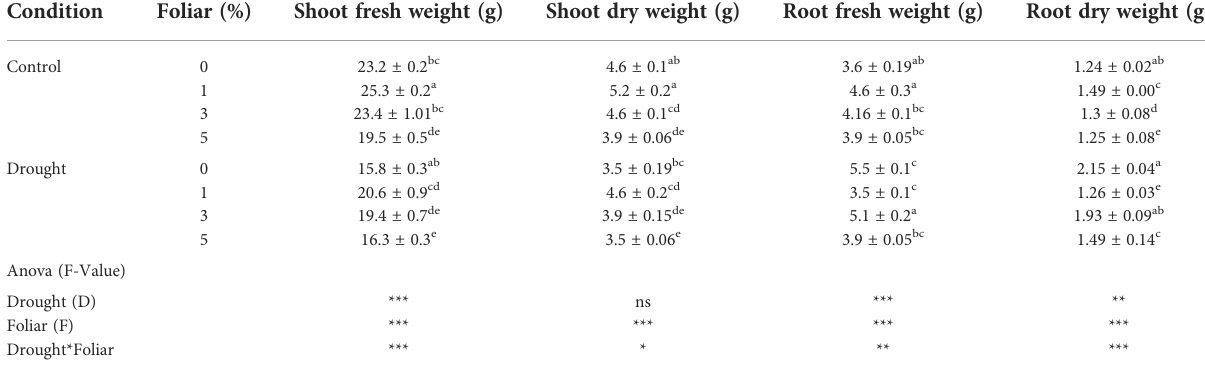
TABLE 1B The effect of foliar application of nano-nutrient solution on plant biomass under drought.